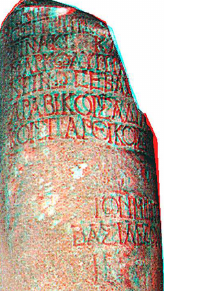
Figure 8. 3D Photogr.of an antique column in Patara (Turkey) allows an enhancement of inscriptions (Photogr. by Schuhr)